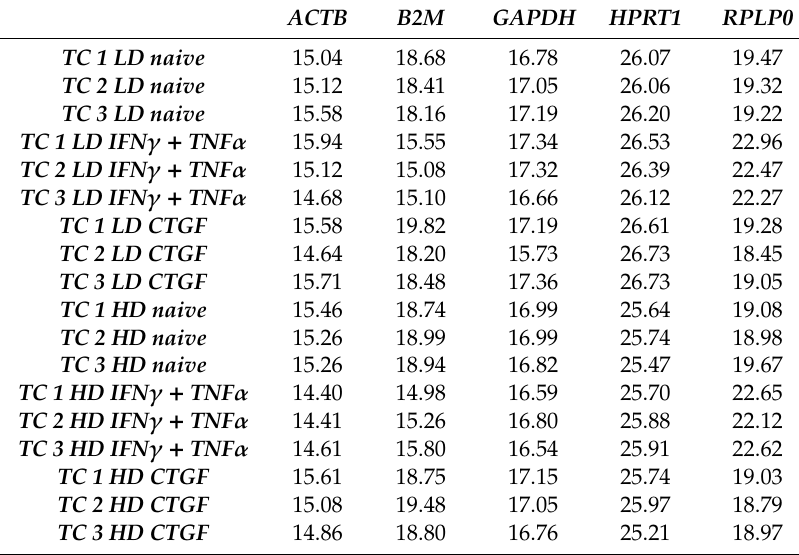
Figure 2. Ct values of tested reference genes (RGs) across tendon cell samples. Table 1. Ct values of tested RGs across tendon cell